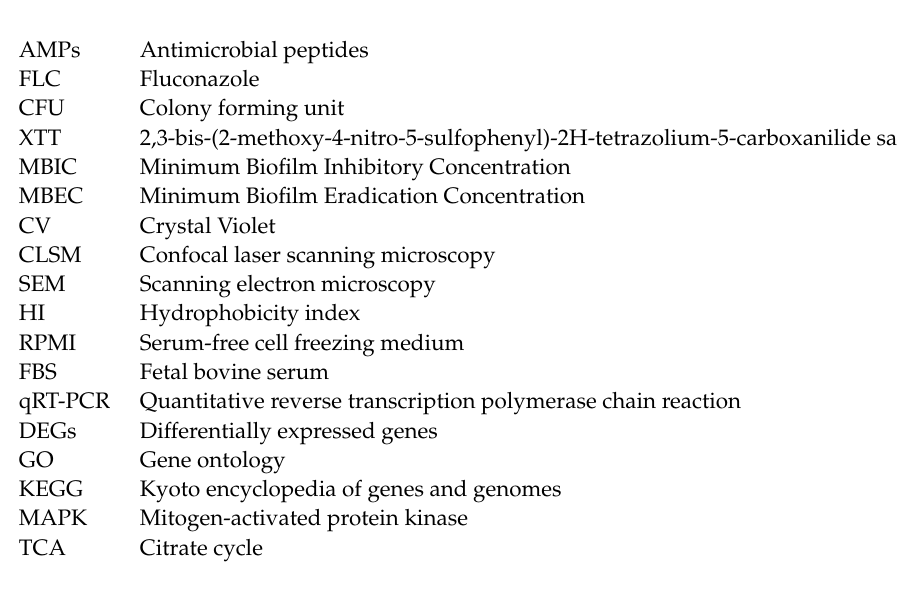
RNA-seq. Table S2: The primers of genes analyzed by qRT-PCR. Table S3: RNA-seq data summary; Table S4: The detailed information of differently expressed genes of AMP-treated forming biofilms obtained by RNA-seq. Table S5: The detailed information of differently expressed genes of AMP- treated preformed biofilms obtained by RNA-seq. Table S6: The DEGs derived from the gene network using Clugo of Cytoscape. Figure S1: Effects of 8 µ g/mL of AMP-17 and FLC on colony morphology on solid Spider medium. Figure S2: Venn Diagram map of DEGs between 32 µ g/mL AMP-17 treated early forming biofilm and 128 µ g/mL AMP-17 treated preformed biofilm. Figure S3: The structure of the gene-gene interaction network based on PPI analysis. Figure S4: The MAPK map of DEGs identified by